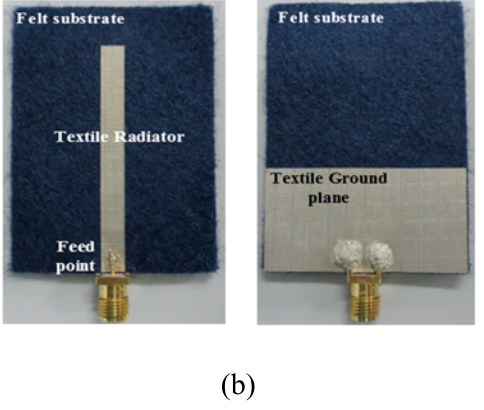
Figure 3: Structure and dimensions of (a) planar TM in millimeters and its (b) fabrication prototype in front and back views [13]. Figure 4 : Simulation setup of TM antenna in the presence of cylindrical phantom model and metallic